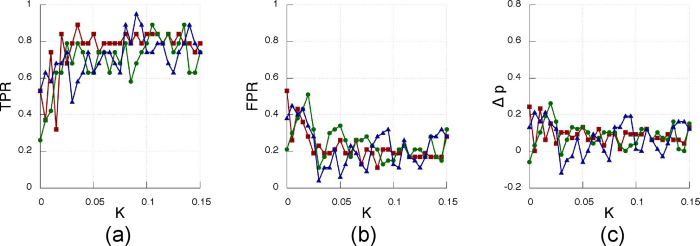
Same as Fig. 10
but for the instantaneous frequencies.